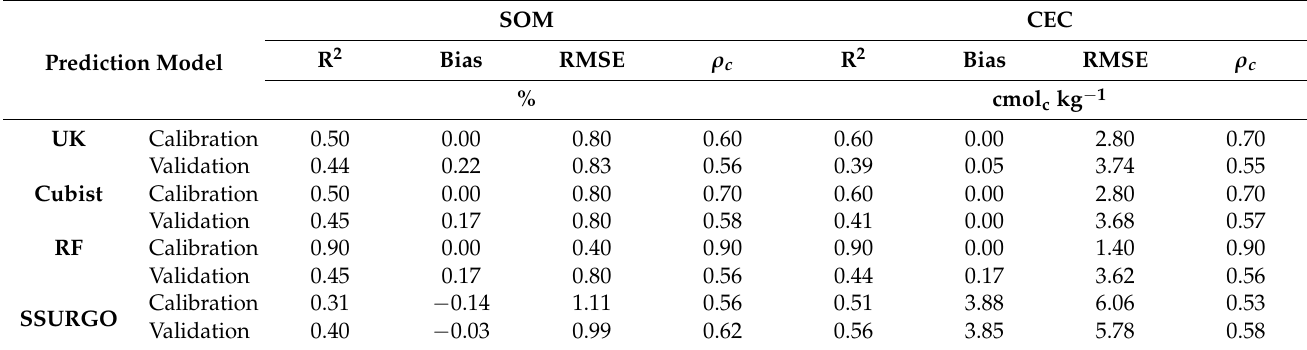
Table 5. Universal kriging (UK), Cubist, and random forest (RF) accuracy assessment for organic matter content (SOM) and cation exchange capacity (CEC) predictions with calibration and validation datasets.